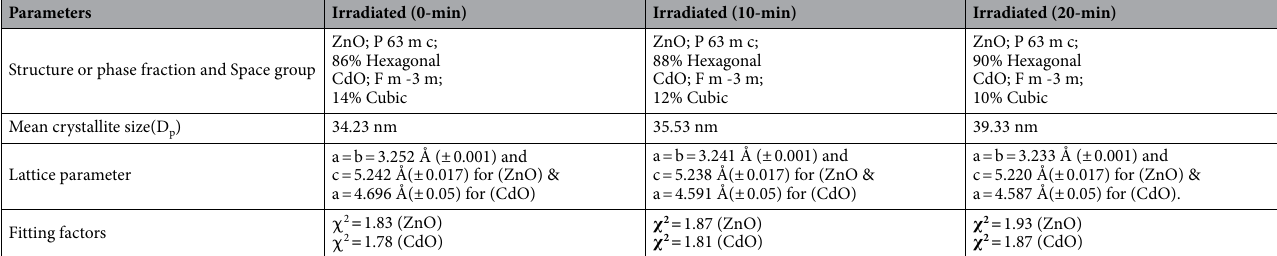
Table 1. XRD refinement parameters and structural information of the ZnO-CdO coated